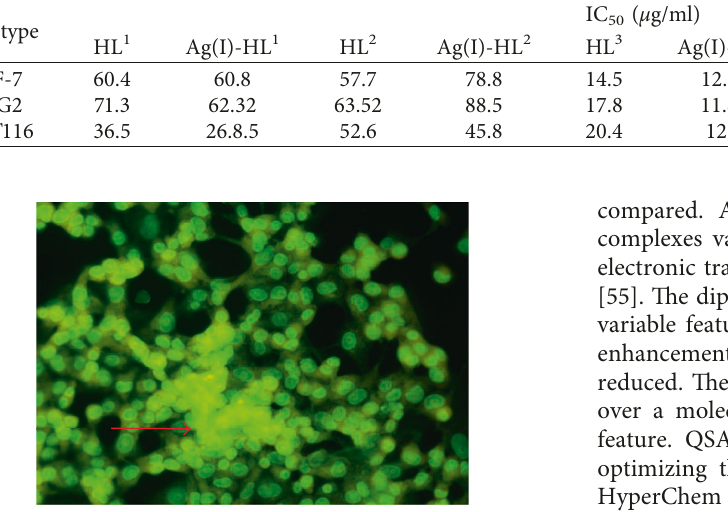
Figure 5: The arrow appeared is attributing to the foci of MCF-7 despite IC 50 of variable